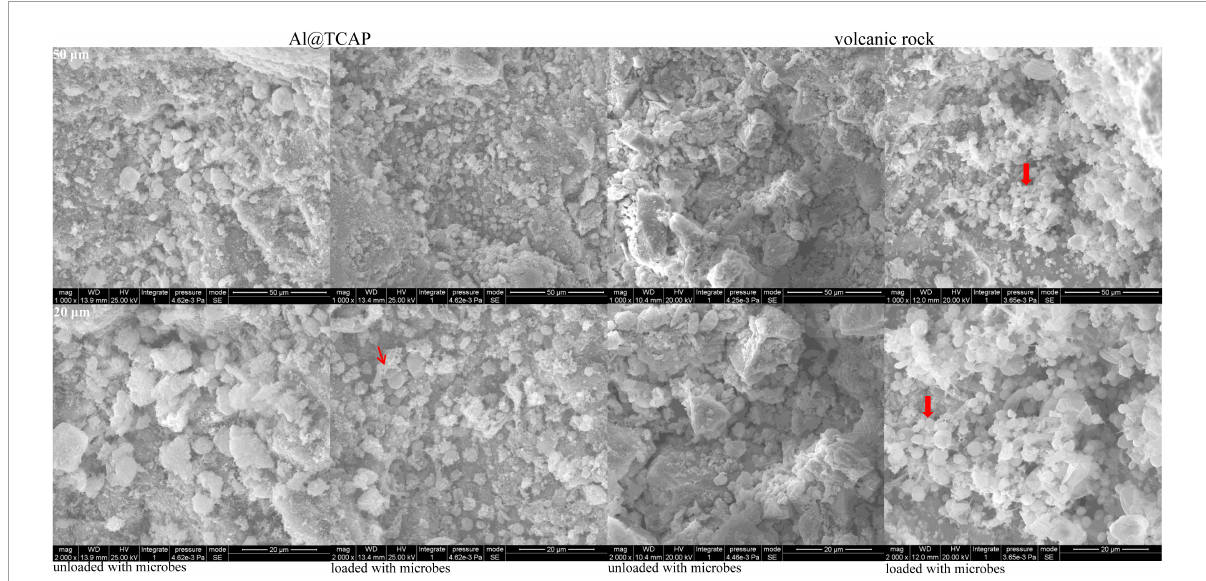
FIGURE1 SEM results for Al@TCAP and volcanic rock when loaded or unloaded with microbes. The red arrow showed loaded with microbes and bacterial film formation. The Al@TCAP surface was rough, uneven, and exhibited many granular protrusions. The surface of the granular protrusions was groove shaped, and there were pores under the granular protrusions. The surface of the volcanic rock had granular protrusions and more pores. The protrusion surface was rough and exhibited a block shape.